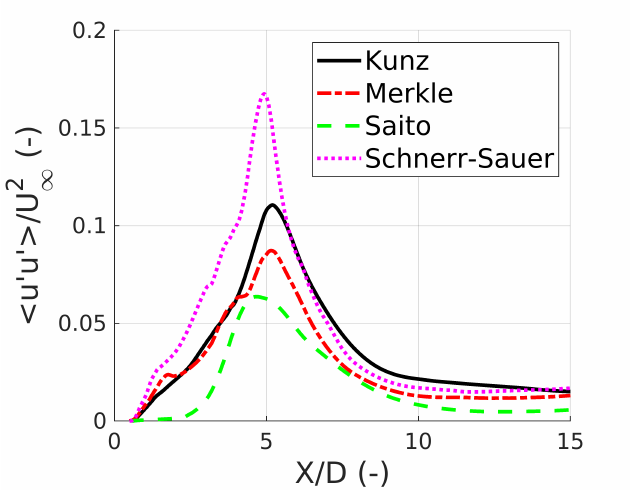
Figure 11. Variance of stream-wise velocity component downstream the cylinder along the centerline, results obtained considering standard